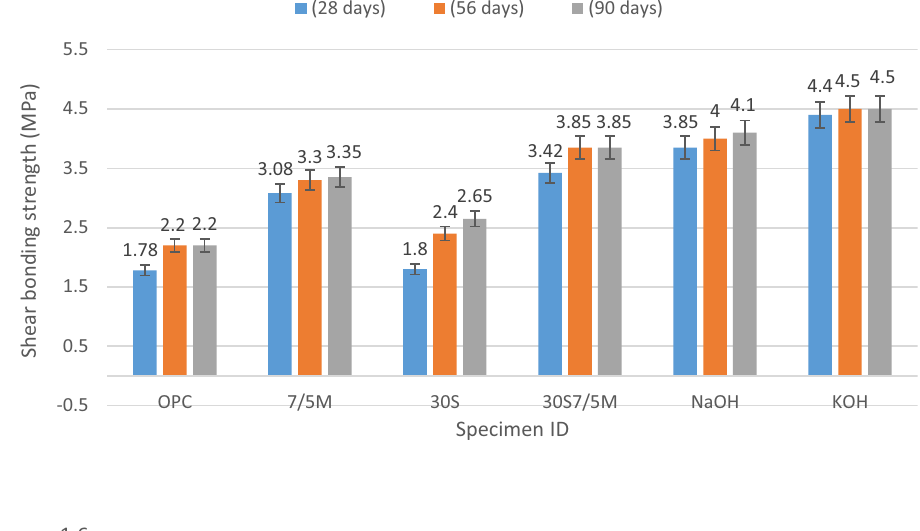
Fig. 11 The tensile bonding strength (Pull-off test)